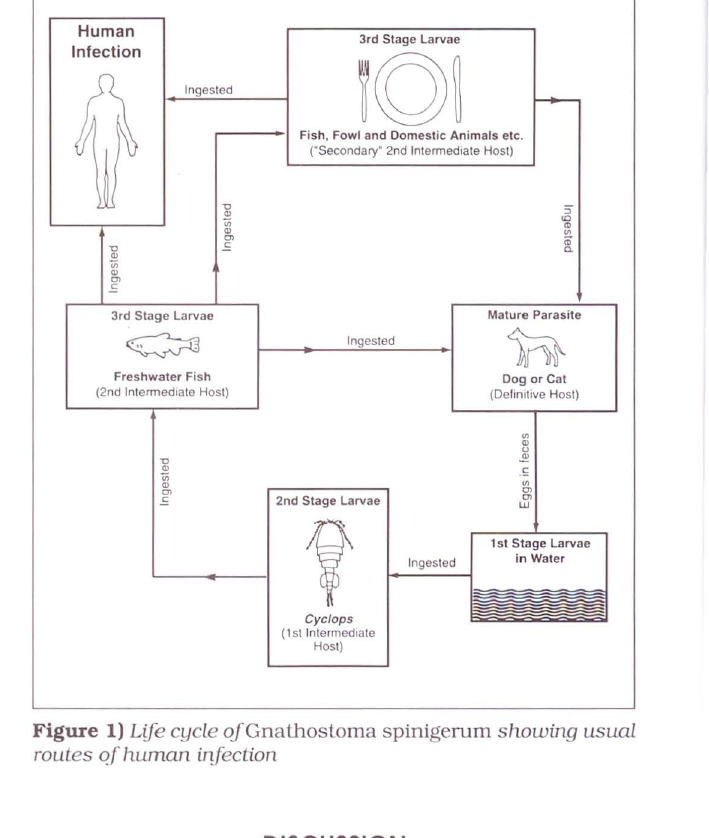
Figure 1) Life cycle of Gnathostoma spinigerum showing usual routes of human infection